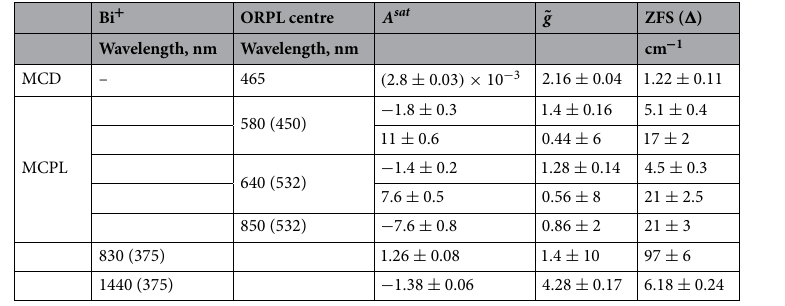
Table 1. Zero field splittings (ZFS), saturation constants and effective ˜ g -factors for ORPL and NIR PL (Bi + ion) centres in SiO 2 :Bi glass. The excitation WL for the MCPL is given in parentheses.